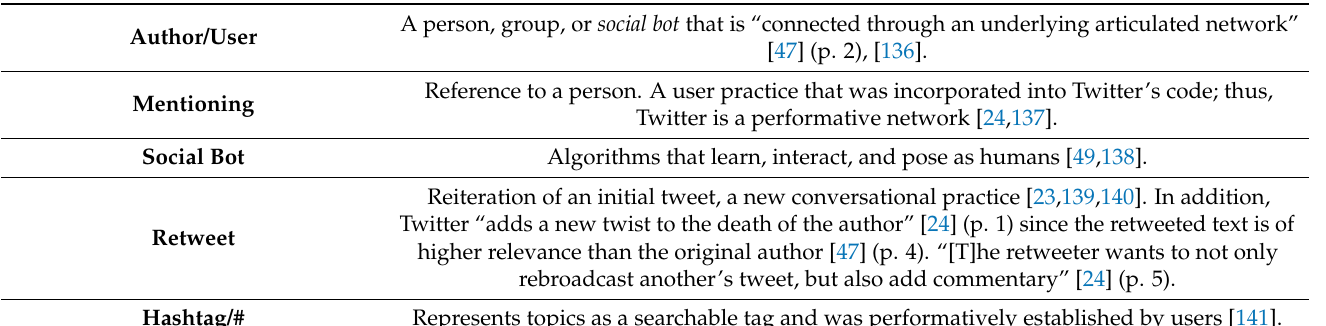
Table 2. Overview of Twitter’s communication